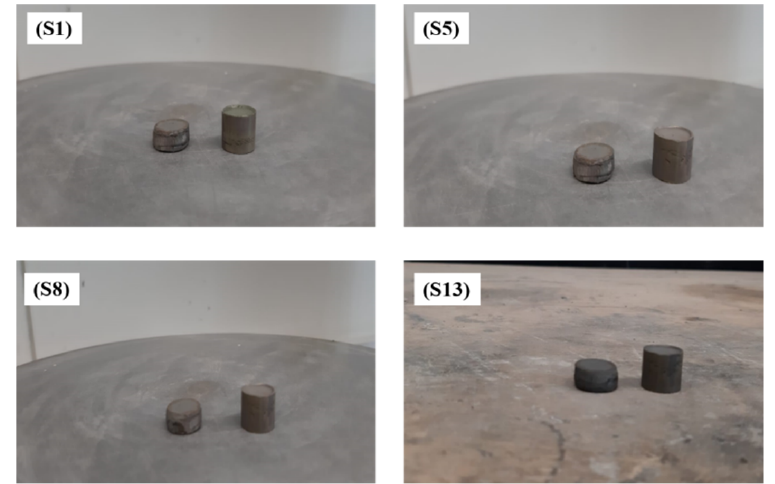
Figure 4. Test samples before and after compression testing.